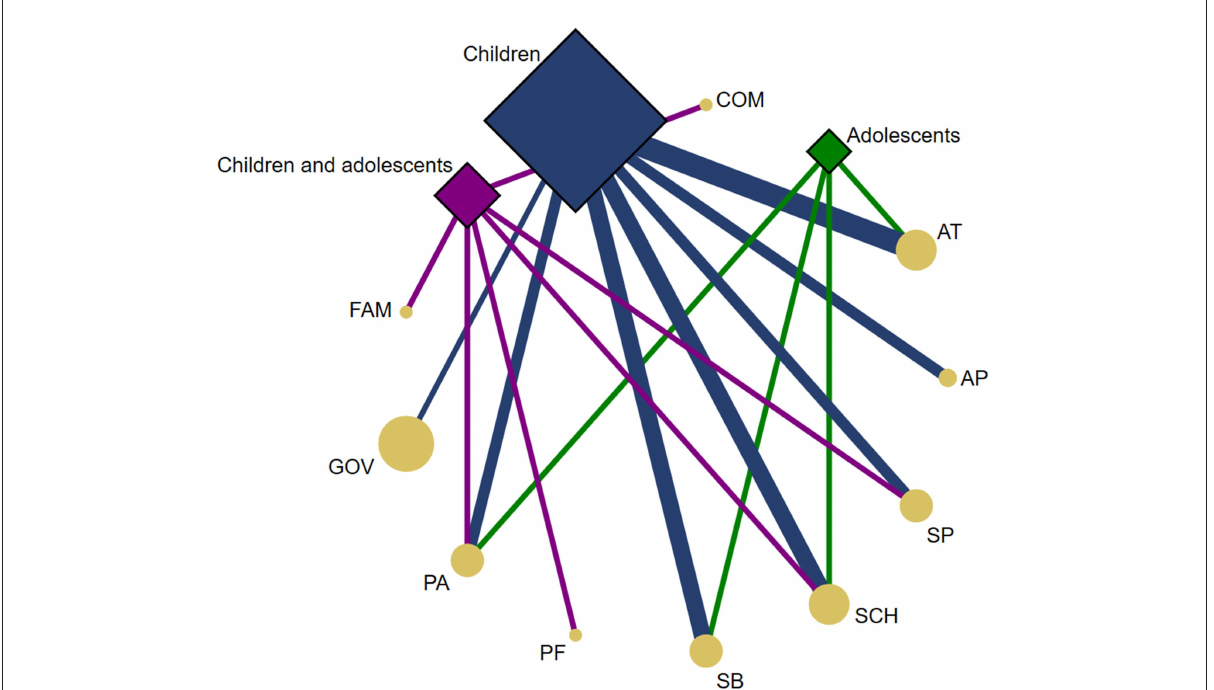
FIGURE2 Network geometry plots of available comparisons between the PA-related indicators and the age groups. The size of the circular nodes (PA-related indicators) was relative to the number of papers analyzing these components. The size of the diamond nodes (age groups) was relative to the number of available data on PA-related indicators analyzing these components. The width of the solid line connecting the nodes was relative to the number of papers analyzing the PA-related indicators (circular nodes) according to age groups (diamond nodes). AP, Active play; AT, Active transportation; COM, Community and built environment; FAM, Family and Peers; GOV, Government; PA, Physical activity; PF, Physical fitness; SB, Sedentary behavior; SCH, School environment; SP, Sport and physical activity